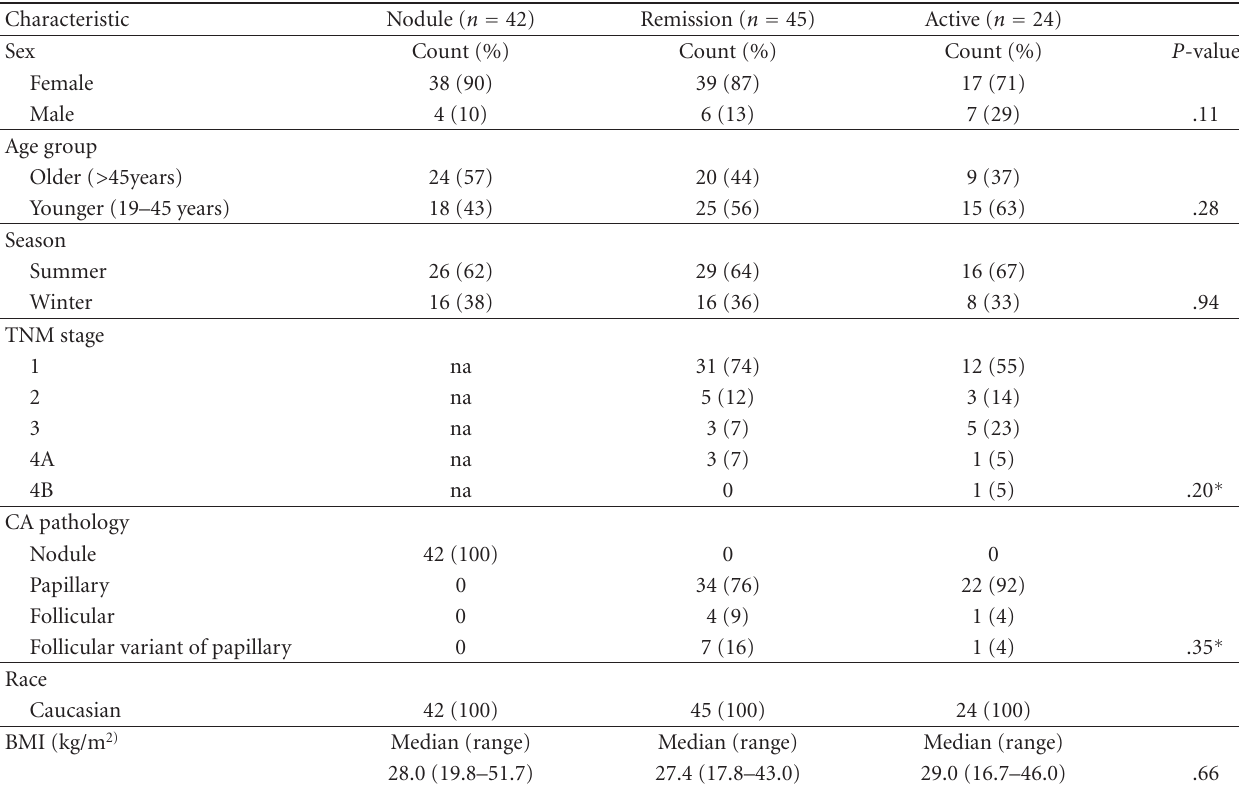
Table 1: Baseline Characteristics.